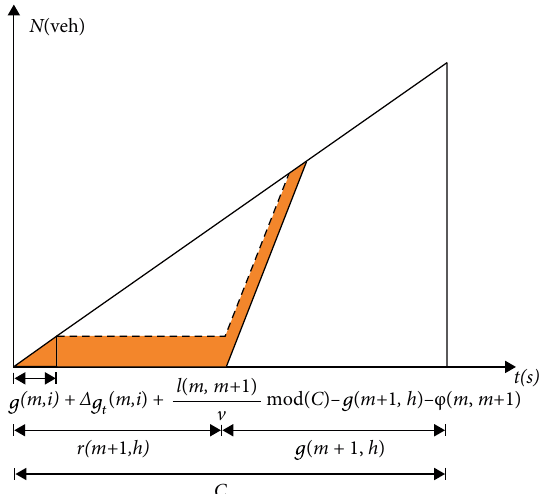
Figure 6: Analysis of nonpriority phase social vehicle